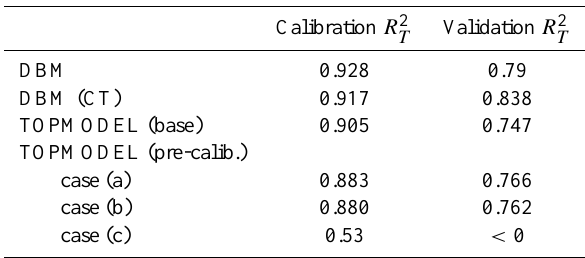
Table 1. Synthetic table of main calibration and validation results.